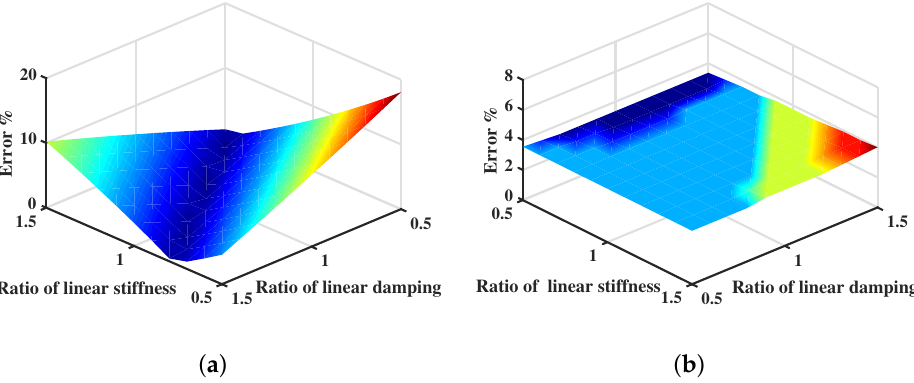
Figure 12. Effects of linear stiffness and damping on errors between reconstructed results and tested results. ( a ) Amplitude; ( b )